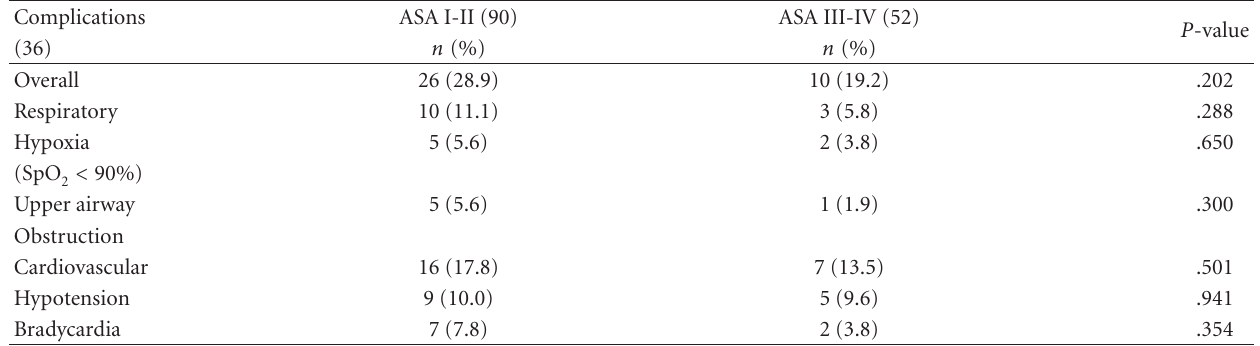
Table 3: Complications comparing ASA physical status